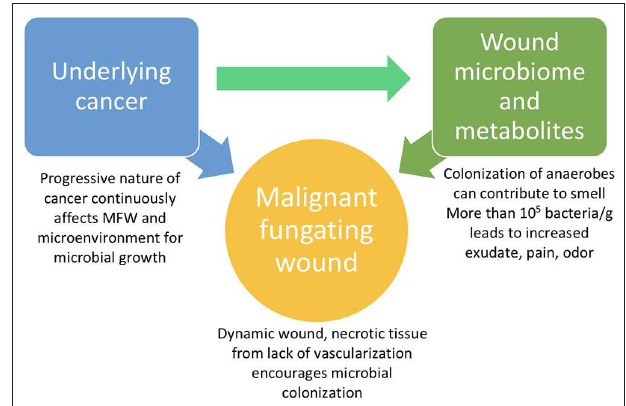
FIGURE 1 | Simplified relationship between the main contributors to MFW